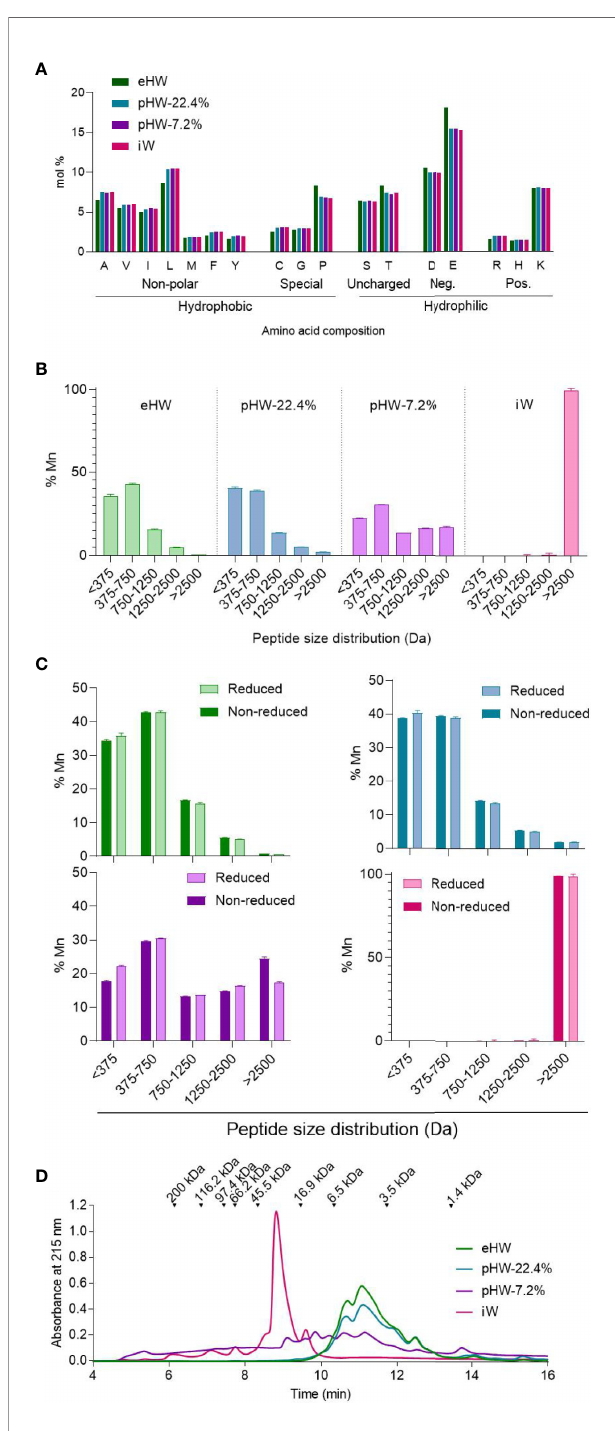
FIGURE 2 | Physicochemical characteristics of whey products. Amino acid distribution (A) , peptide size distribution under reduced condition (disulphide bonds and non-covalent interactions disassociated) alone (B) or in comparison to the non-reduced condition (non-covalent interactions disassociated) (C) , and aggregation status under physiological conditions (no interactions disassociated) (D) of extensively (eHW), partially hydrolysed (pHW-22.4% or pHW-7.2%) or intact (iW) whey products. Mean and standard deviation of triplicates (B, C) . Mn, number average molecular